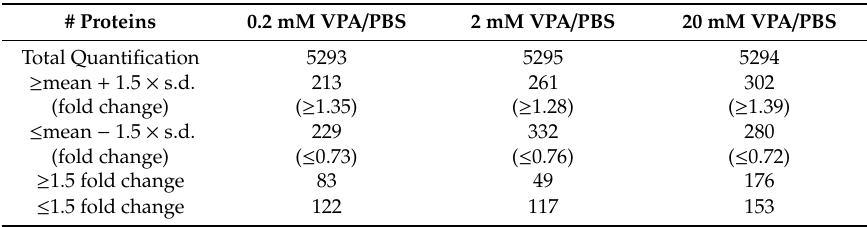
Table 1. Summary of quantification results.